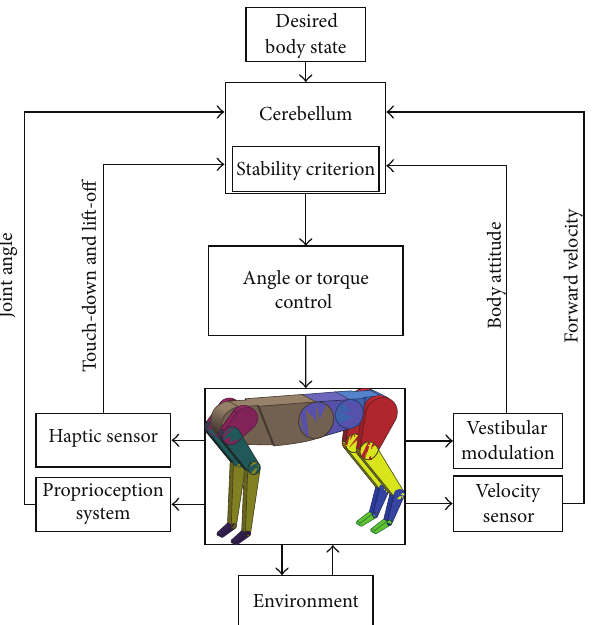
Figure 3: The diagram of the bioinspired